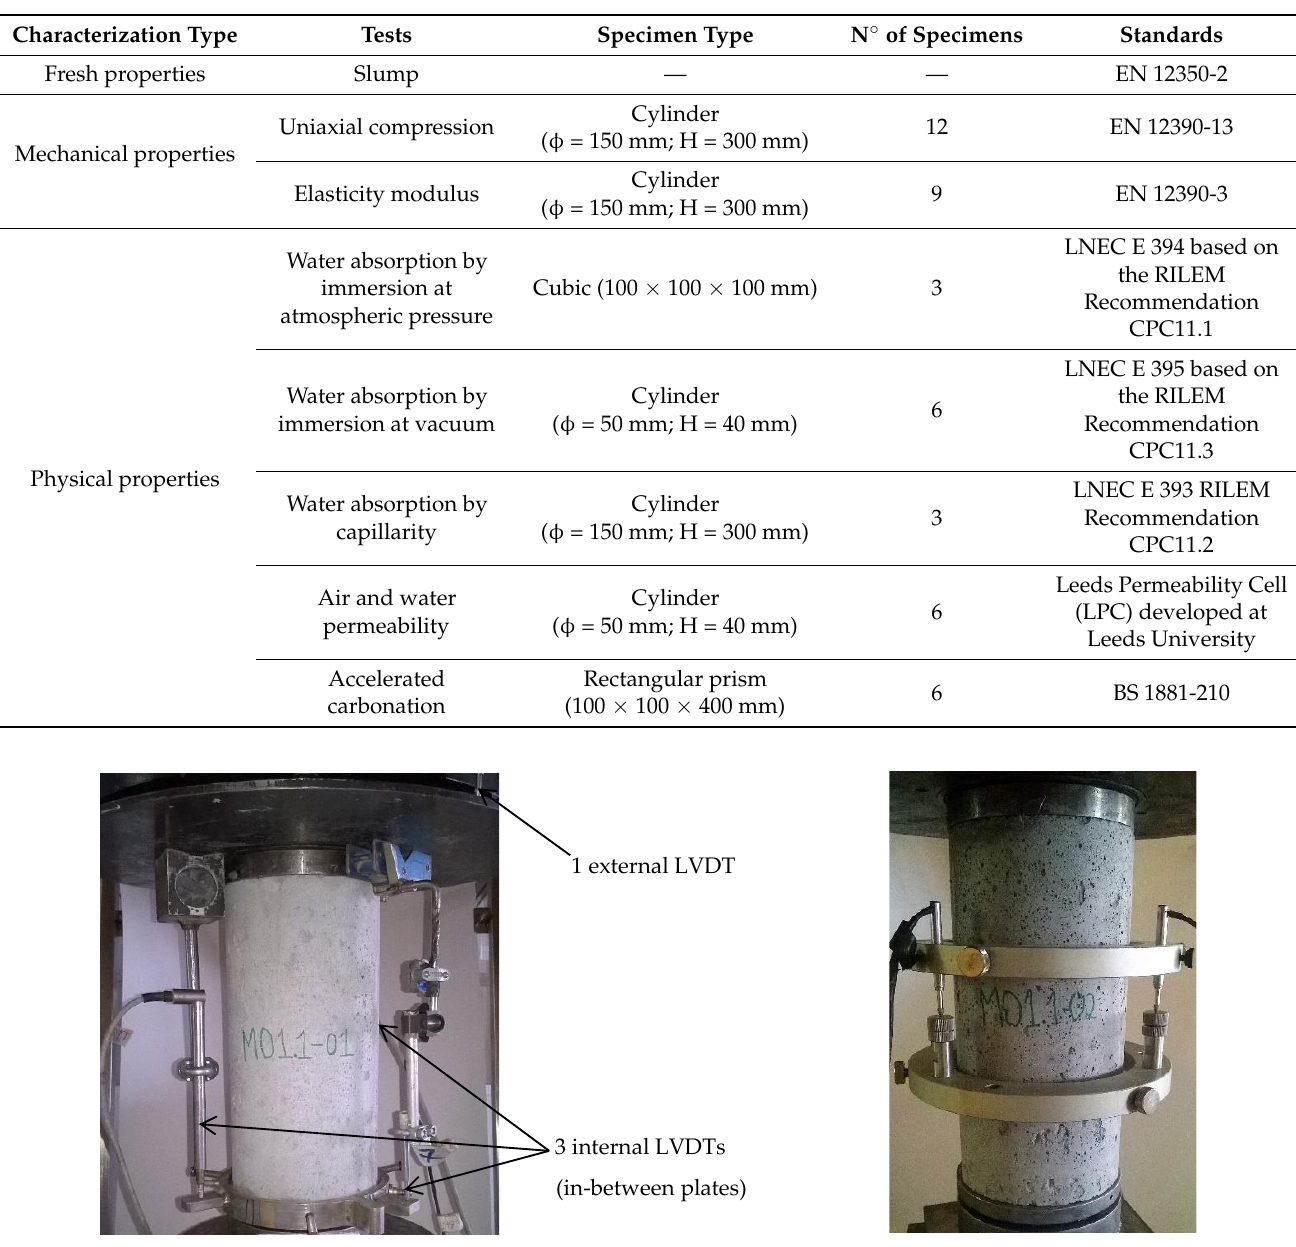
Table 8. Summarized scheme of the overall tests performed for each type of concrete mixture.